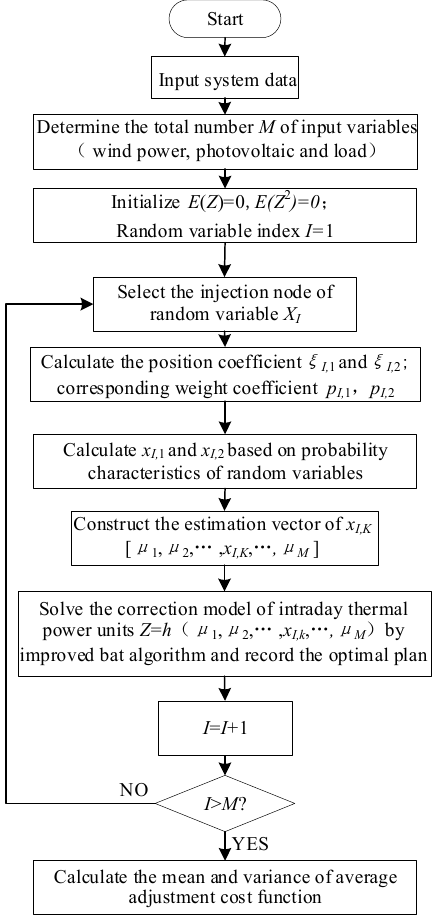
Figure 4. Flow chart based on the two-point estimation method.